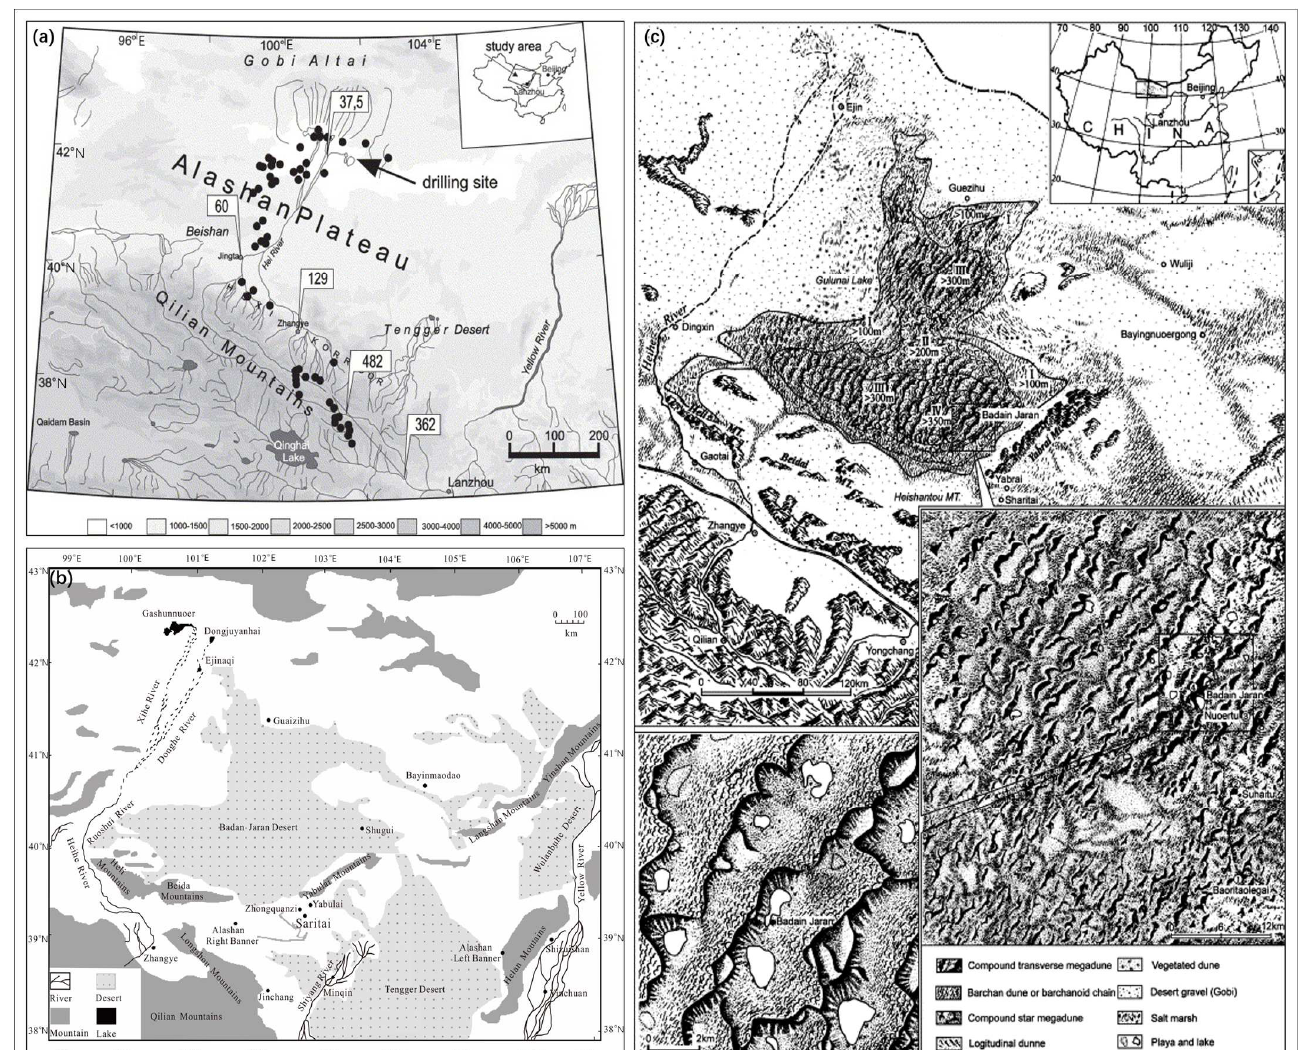
Figure 1. ( a ) Geographical locations of the pollen sample sites and the coring site on the Alashan Plateau discussed in this paper; ( b ) spatial distribution of the tree-lined large sand deserts on the Alashan Plateau; and ( c ) the aeolian landforms in the Badanjilin Desert (modified after [11,16,32]). Black dots in ( a ) indicate the detailed pollen sample sites and the coring site, and the numbers indicate the annual sum of precipitation in mm.